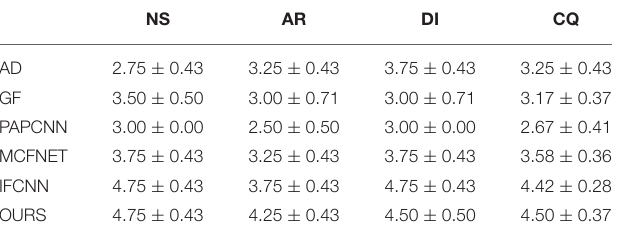
TABLE 2 | Image quality evaluation scores of different algorithm results.